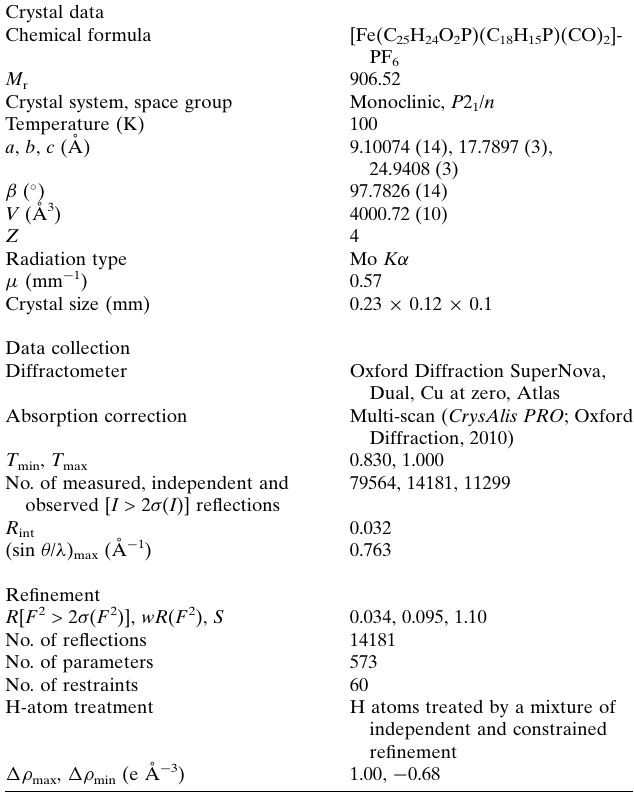
Synthesis and crystallization To a solution of dicarbonyl(1-methoxycarbonylpentadienyl)-